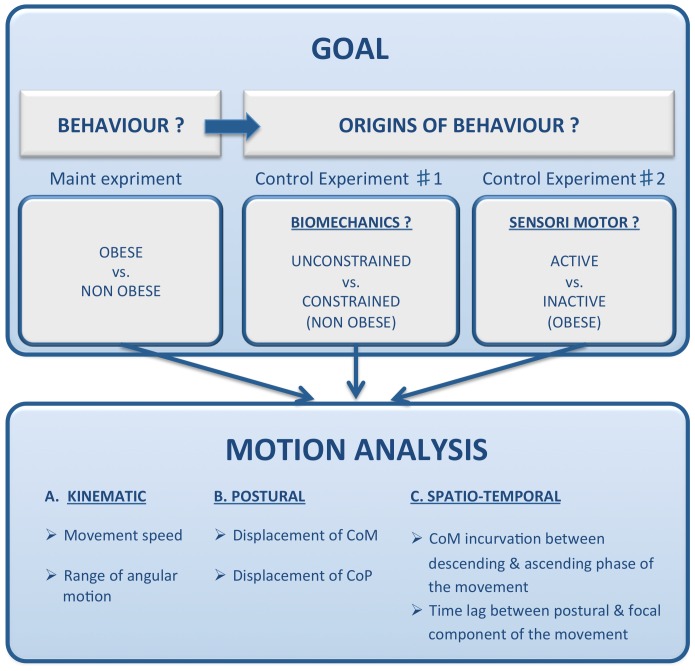
Illustration of the experimental design and framework hypotheses.The differences in posturo-kinetic behaviour (Main experiment) was investigated first; then, the role of some biomechanical (control experiment #1) and sensory-motor (control experiment #2) factors underlying these postural/motor deficits was identified by comparing unconstrained vs. constrained non obese participants and active vs. inactive obese patients, respectively.